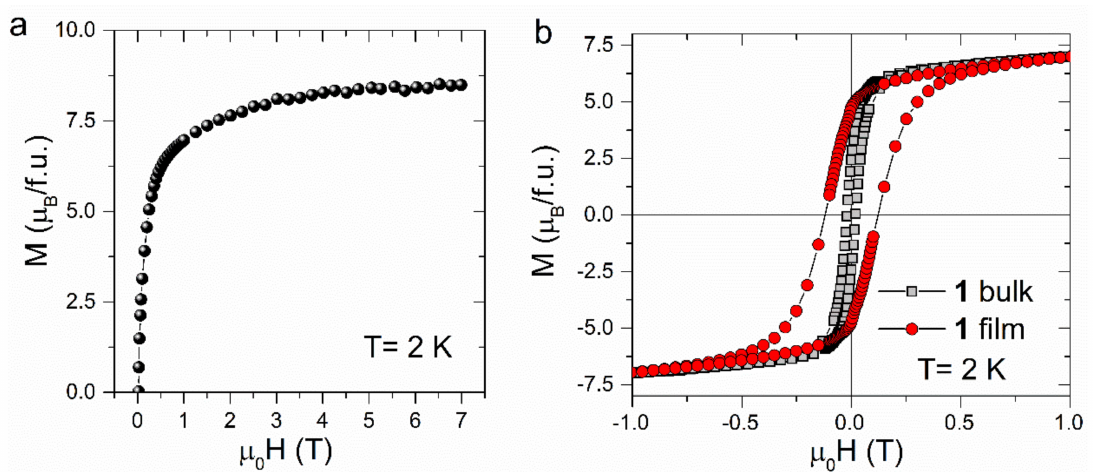
Figure 8. M(H) dependence ( a ) and hysteresis loop ( b ) measured for (1) film at T = 2 K. The hysteresis plot obtained for the bulk sample is included for comparison.